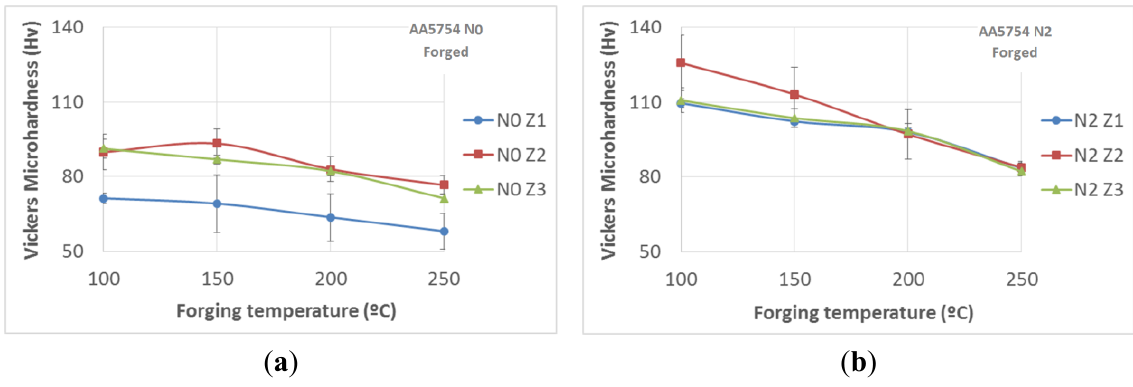
Figure 3. Hv microhardness vs. forging temperature for N0 and N2 states: ( a ) N0; ( b ) N2.